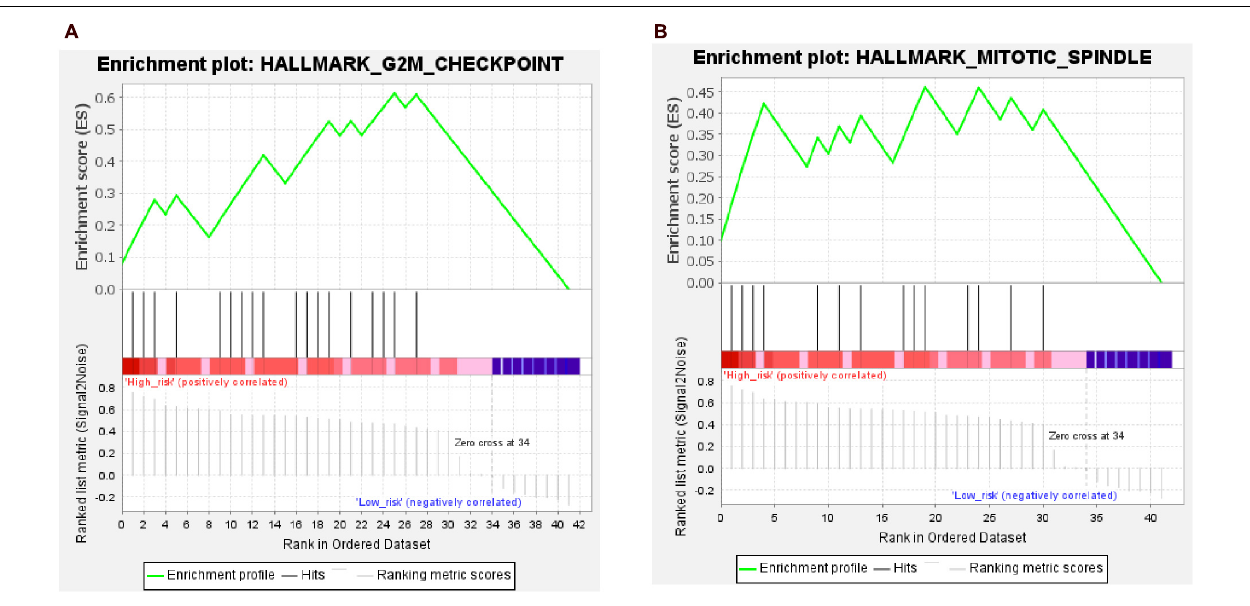
molecular subtyping systems, which were based on the assessment of 363 endometrial carcinomas, enable a better understanding of the tumorigenesis of EC and improve treatment decisions and outcomes. Here, more samples